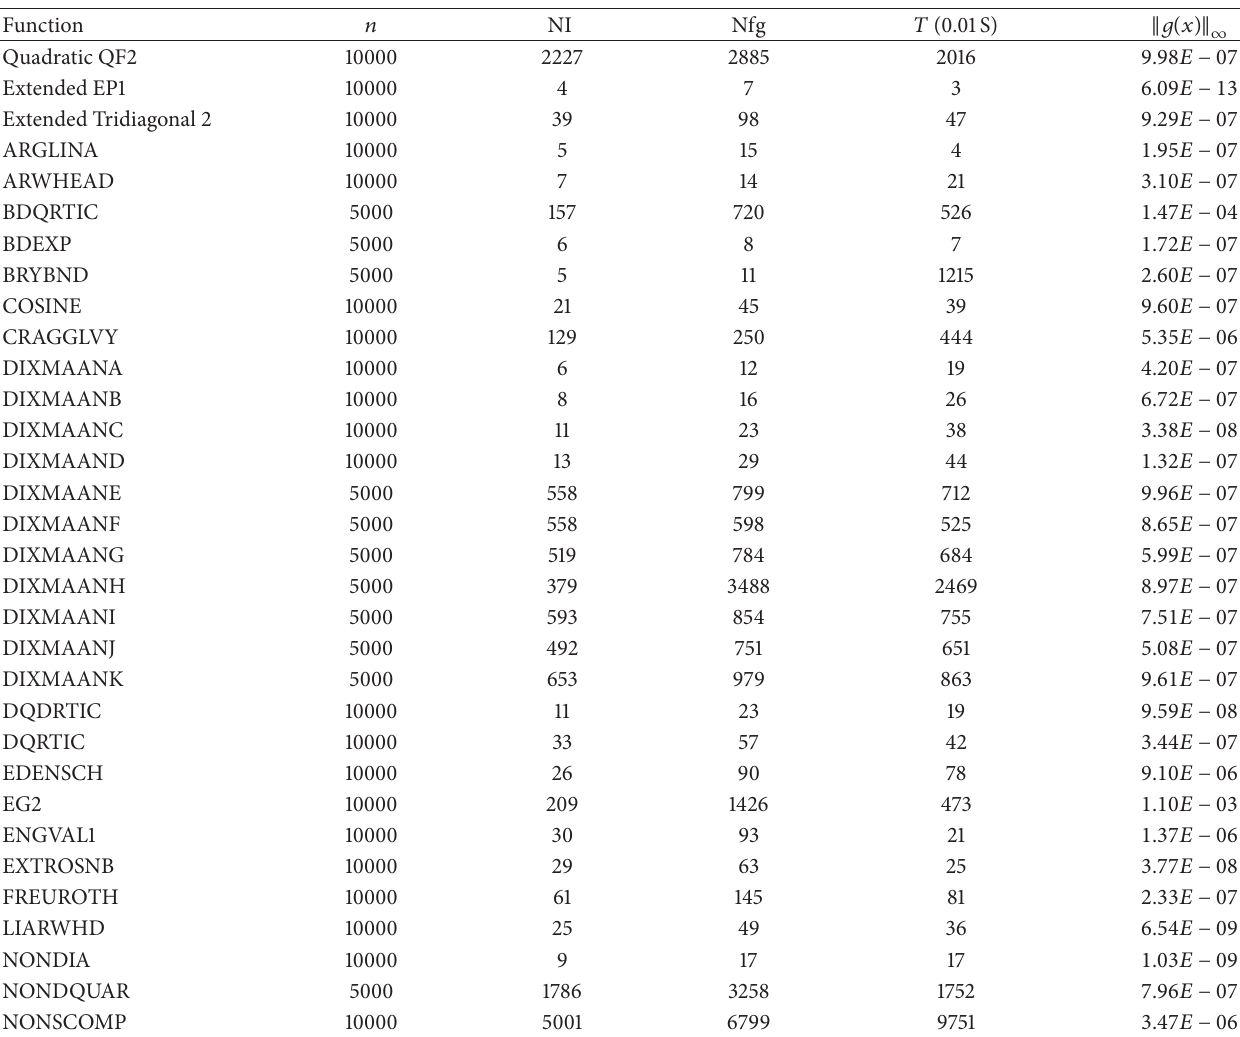
Table 1: Numerical results for PRP +